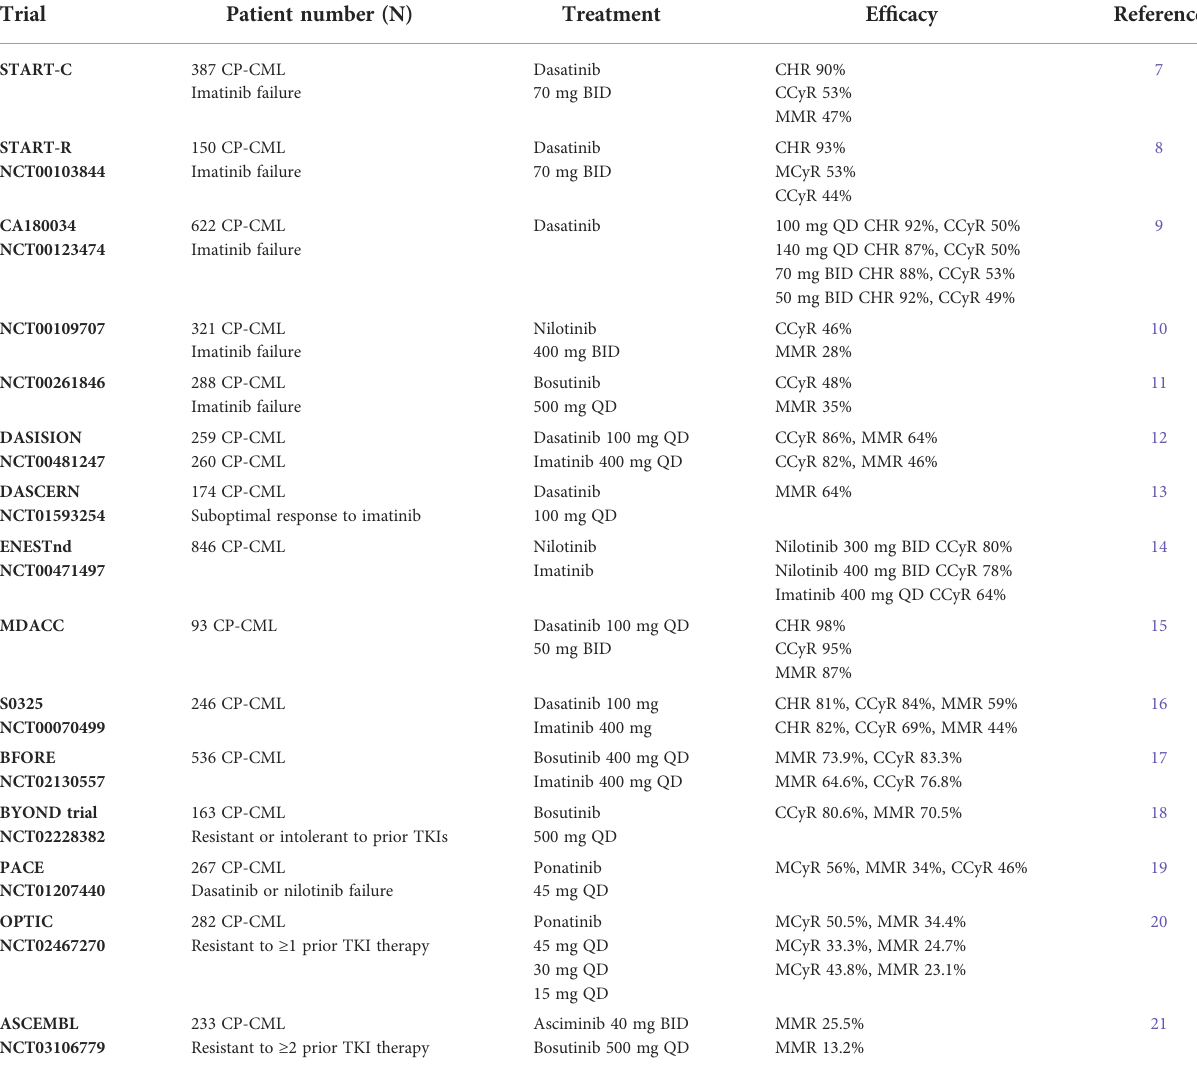
TABLE 1 TKI treatment of CP-CML